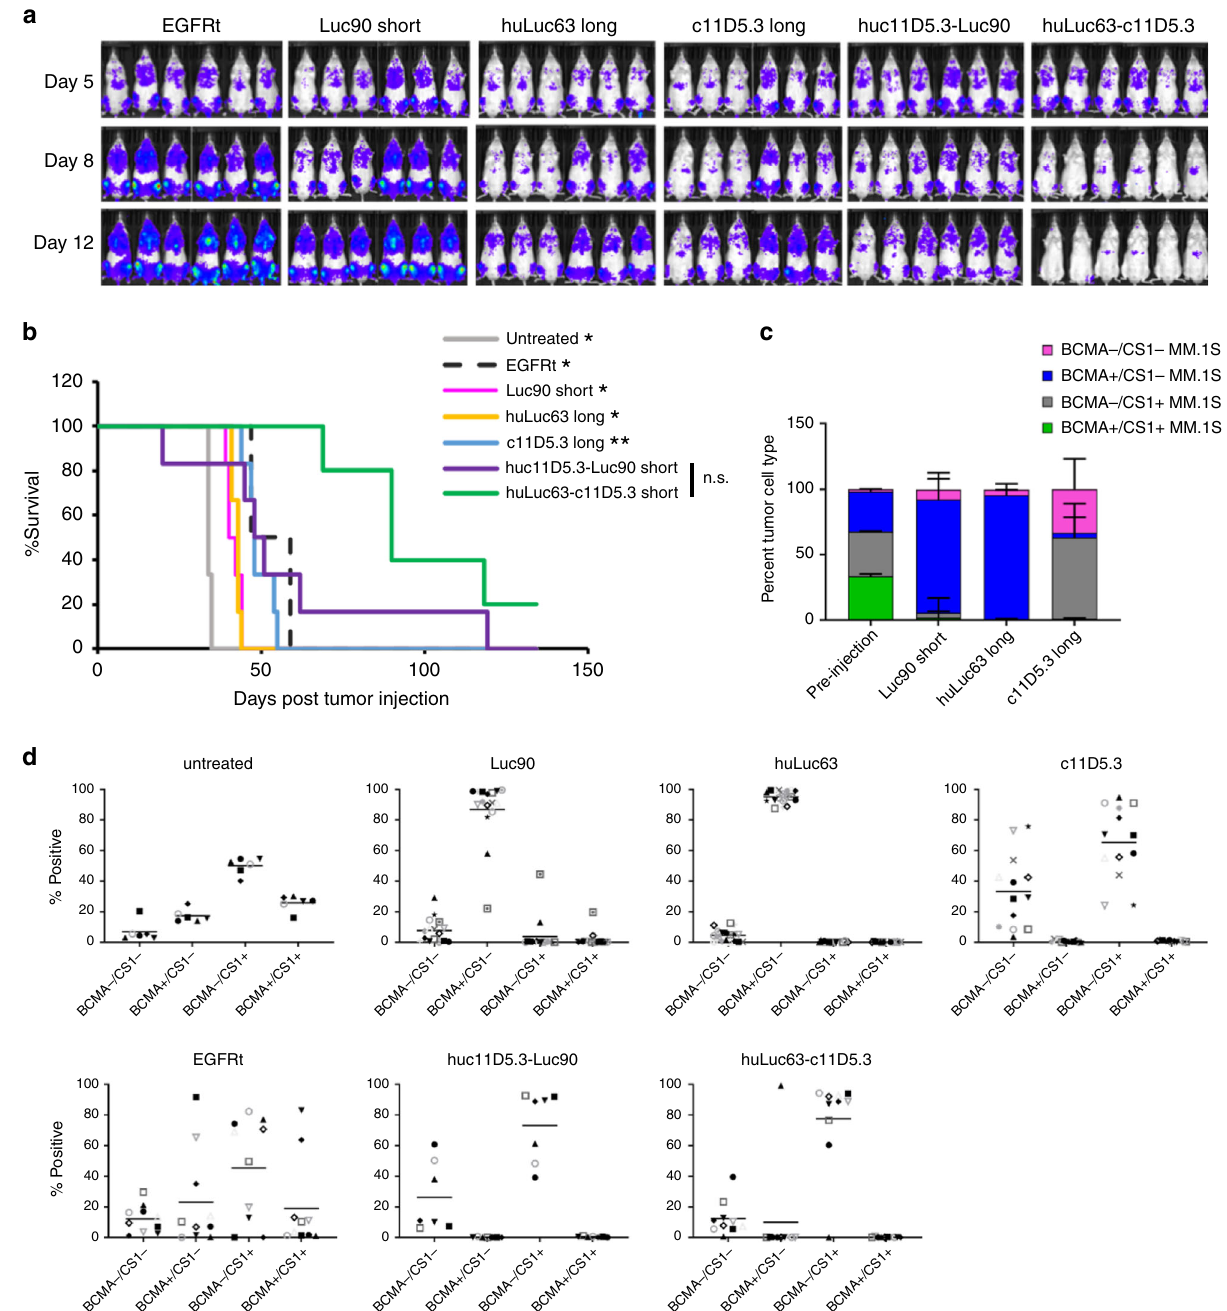
Fig. 4 BCMA/CS1 OR-gate CAR-T cells prevent antigen escape in vivo. a Evaluation of single-input and bispeci fi c CAR-T cells in vivo. Mice were engrafted with a mixture of 1.5 × 10 6 MM.1 S cells containing a 1:1:1 ratio of BCMA + /CS1 − , BCMA − /CS1 + , and BCMA + /CS1 + cells. Tumor-bearing animals were treated with 1.5 × 10 6 EGFRt- or CAR-expressing T cells on day 5 (5 days after tumor injection) and day 13. Six mice were included in each initial treatment group but only fi ve mice in the huLuc63-c11D5.3 group were redosed due to limited T-cell availability. Tumor progression was monitored by bioluminescence imaging. b Survival of mice shown in a . Statistical difference (depicted) between survival of huLuc63-c11D5.3-treatment group compared with other treatment groups was determined using log-rank analysis, applying a Chi-square distribution with one degree of freedom; n.s. not statistically signi fi cant ( p > 0.05); * p < 0.05; ** p < 0.01. P- values for the different treatment groups are as follows: Untreated, p = 0.024; EGFRt, p = 0.024; Luc90, p = 0.011; huLuc63, p = 0.015; c11D5.3, p = 0.008; huc11D5.3-Luc90, p = 0.114. c BCMA/CS1 antigen ex p ression on tumors harvested from mice treated with CS1 single-input Luc90 Short, huLuc63 Long, or BCMA single-input c11D5.3 Long CAR-T cells. Values shown are the means of n = 4 technical replicates for cells stained prior to injection. Thirteen to 18 tumor samples were collected from different locations in the mice (six mice per test group) at the time of sacri fi ce, with error bars indicating + 1 standard deviation (SD), and each sample corresponding to 100 or more events as detected by fl ow cytometry. d Antigen expression pattern on tumor cells recovered at the time of animal sacri fi ce. Each data point d corresponds to an individual tumor sample recovered that included more than 100 tumor cells as detected by fl ow cytometry; each mouse generally contained multiple tumors at the time of sacri fi ce. Source data are provided as a Source Data